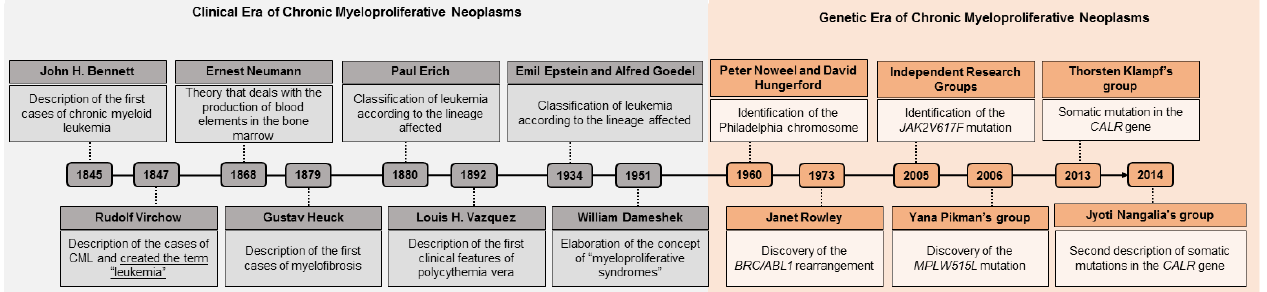
Figure 1. Timeline of myeloproliferative neoplasms. In gray, the clinical era of the MPNs can be seen, which is based on semiological aspects. In orange, the genetic era of MPNs is highlighted, since associated genetic research made it possible to identify genetic alterations that are markers of some MPNs, an important factor that supports diagnosis. CML: chronic myeloid leukemia; BCR/ABL: BCR/ABL genetic rearrangement.